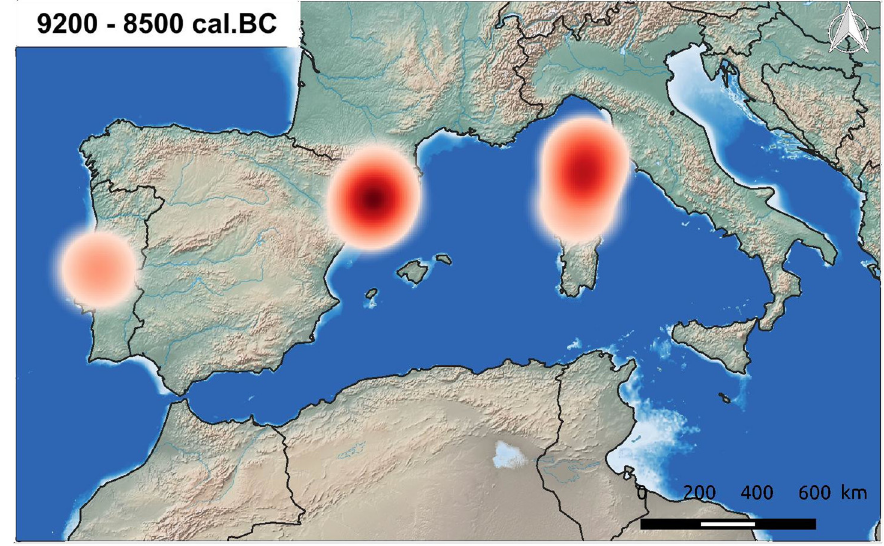
Figure 6: Heat map of the main earliest occupations of the MMD technocomplex, between 9200 and 8500 cal.